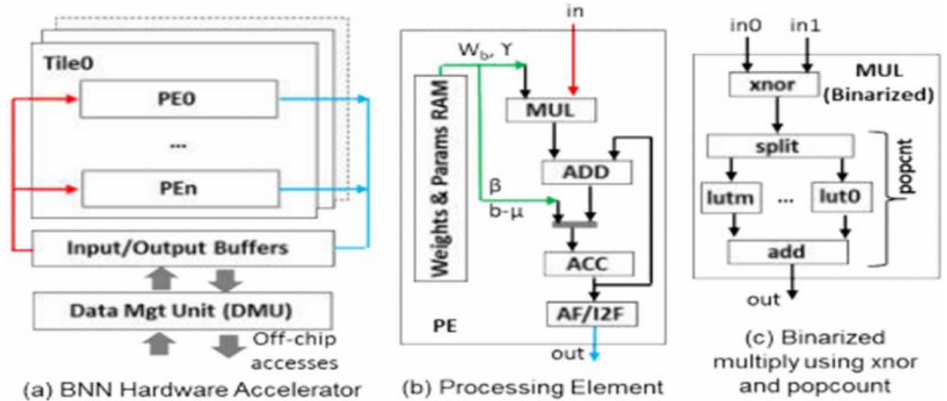
Figure 3. BNN hardware accelerator architecture [24]. (Reprinted with permission from ref. [24]. Copyright 2021 IEEE).